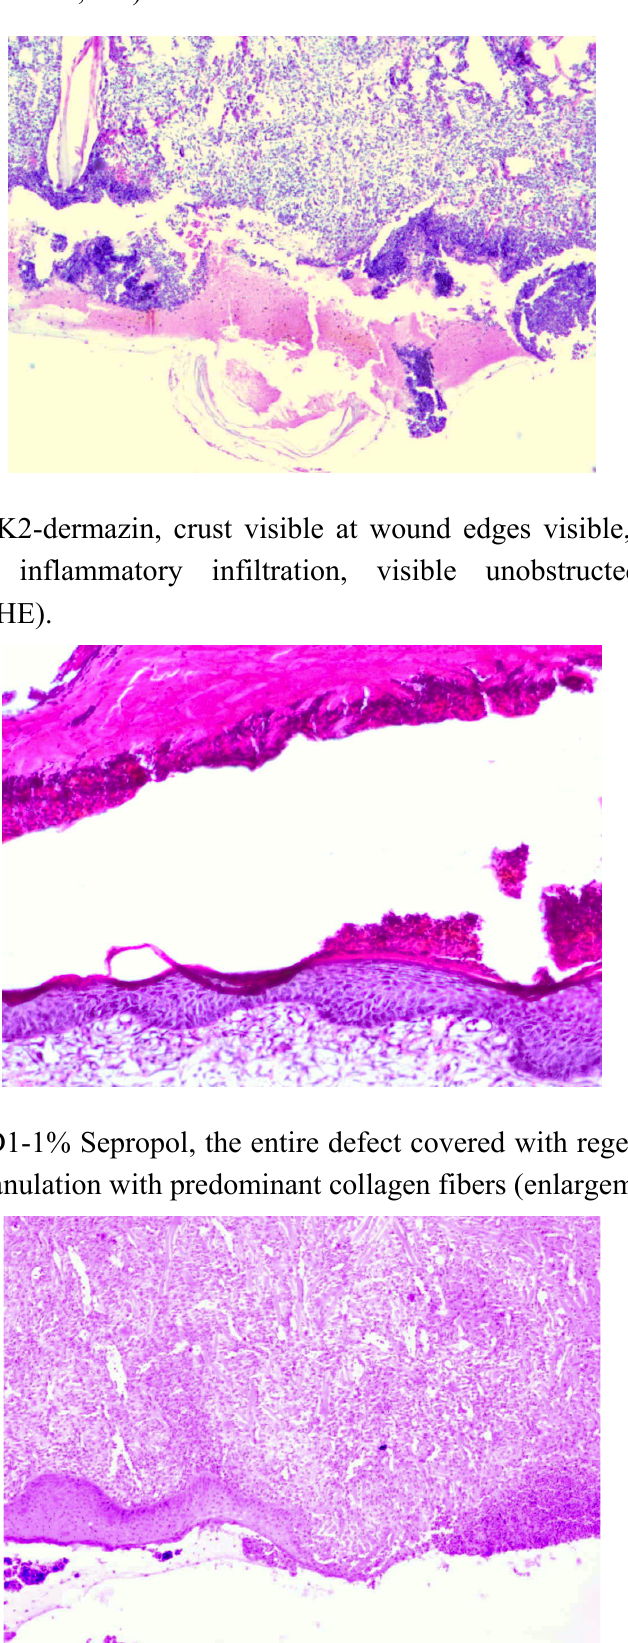
Figure 5. Day 21, K1-0.9% NaCl, defect visibly filled in with granulation tissue and crust covering the wound, inflammatory infiltration reach granulocytes within the skin damage borders (enlargement 150×, HE).